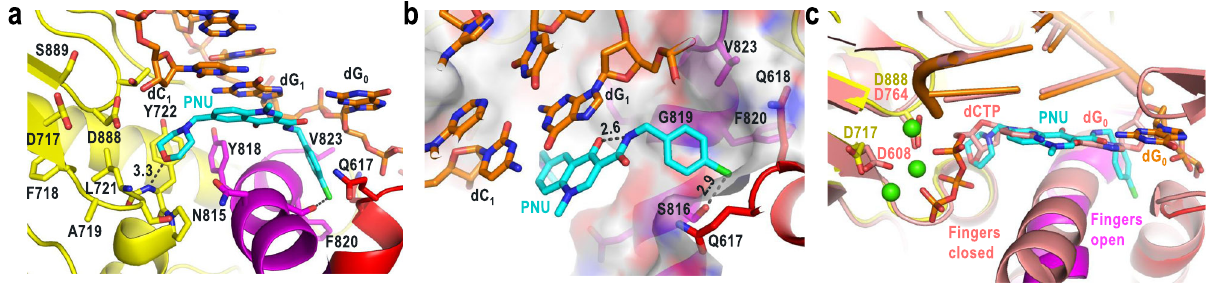
Fig. 4 HSV1 polymerase active site and interactions with PNU-183792. a HSV1 polymerase active site and interactions with PNU. b PNU p-chlorobenzyl interactions and intramolecular hydrogen bonding. c Overlay of HSV1 pol and yeast pol δ (PDB:3IAY [https://doi.org/10.2210/pdb3iay/pdb]) ternary complex structures at polymerase active site. The yeast pol δ protein and active site Ca 2 + ions are colored salmon and